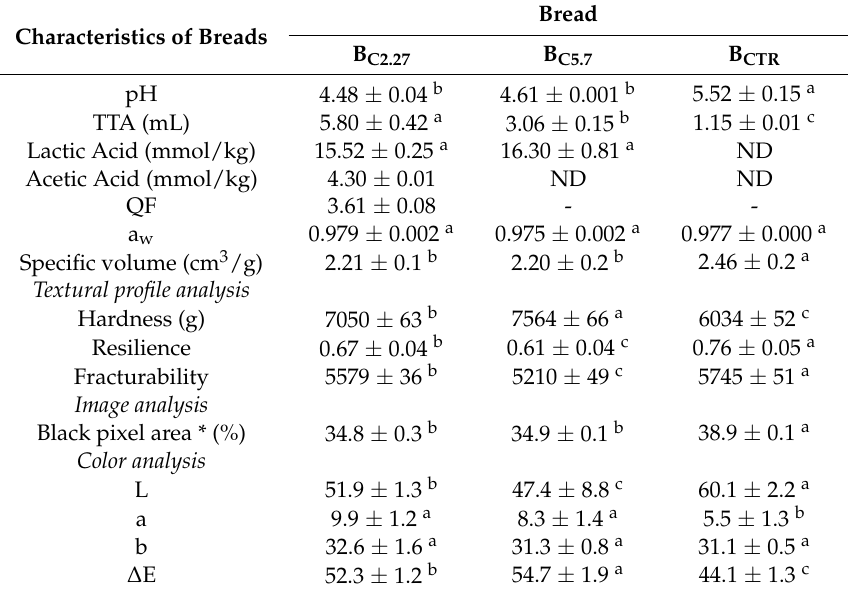
Data represent means of three independent experiments ± standard error. a–c Values in the same row with different letters differ significantly ( p < 0.05). * The gas cell area is expressed as the percentage of black pixel to total area of the image. ND: Not detected (<LOD).